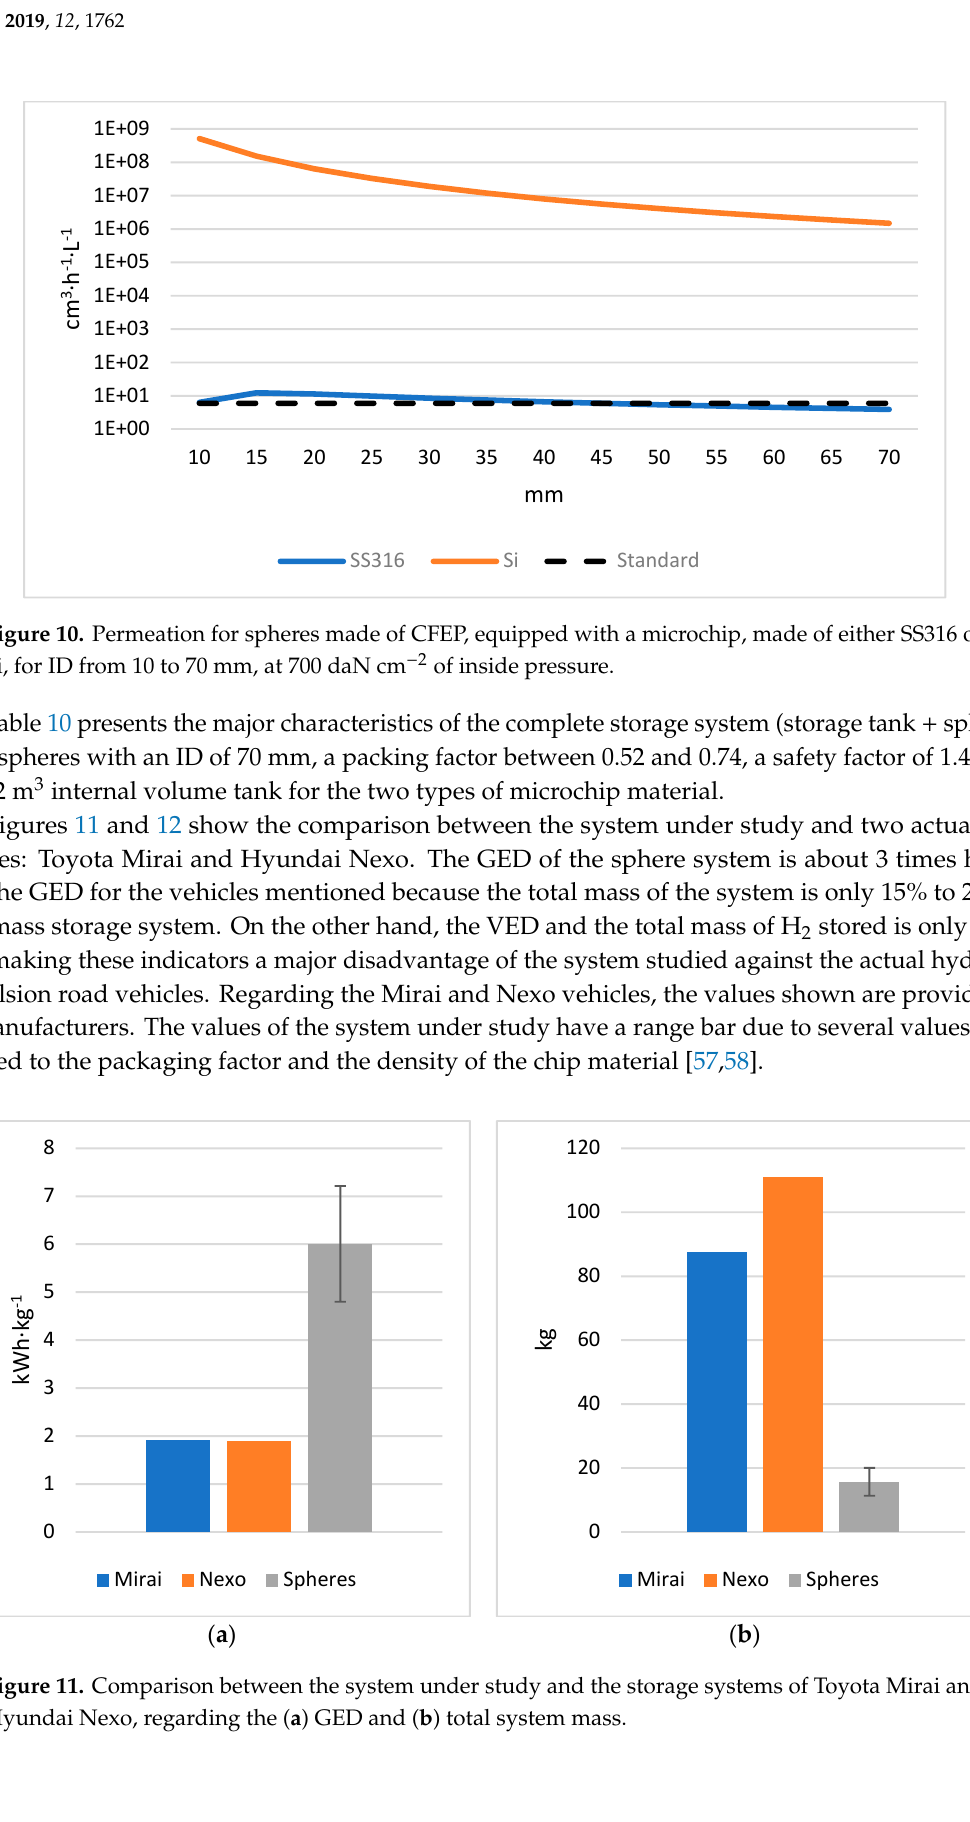
( b ) Figure 12. Comparison between the system under study and the storage systems of Toyota Mirai and Hyundai Nexo, regarding the ( a ) VED and ( b ) the mass of stored hydrogen. 5. Conclusions The hydrogen storage system studied in this paper is safer than the conventional systems for the same purpose, since the mass of hydrogen is divided, as required, in several small spheres containing nonhazardous amounts of fuel. The chief advantage of this system, when compared with systems already adopted by car manufacturers, is its GED, whereas it performs not so well in terms of VED. It exceeds the target set by the US DoE of GED = 1.5 kWh kg − 1 and of VED = 0.8 kWh L − 1 . Moreover, both GED and VED increase with increasing internal diameters of spheres. The leakage across spheres is negligible when compared with the leakage across the microchip. However, it must be stressed that, regarding leakage, not all materials are suitable for the construction of the microchip, namely Si. The packing factor must be as high as possible to increase the GED and VED, which is achievable through vibration, lubrication, the speed at which the spheres are introduced into the envelope tank, and the possibility of using spheres with different diameters.